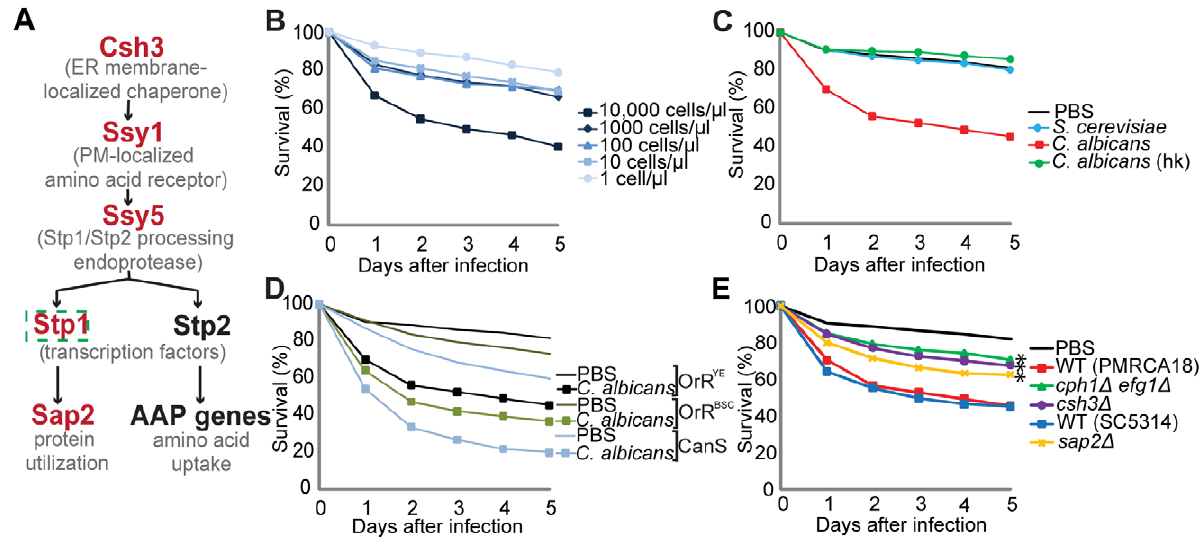
Figure 1. Drosophila can be used as a model of C.albicans virulence. A. The epistatic relationships of the components of the SPS sensing pathway in C. albicans . Strains carrying null alleles of the genes in red type exhibit reduced virulence in the Drosophila host model. The dashed-line around STP1 indicates that this gene is nitrogen regulated, and is only expressed under conditions of limiting nitrogen-source availability. Stp1 activates genes involved in host protein degradation and utilization, such as the gene encoding the Sap2 protease. Stp2 activates genes required for amino acid uptake, such as genes for amino acid permeases (AAPs). Note that Ssy1 is identical to Csy1 [14]; Ssy1 is used here since it is the standard name listed in the Candida Genome Database. B. Wild-type Drosophila (OrR YE ) flies are susceptible to virulent C. albicans infections and can be used as a model host to assess the virulence properties of mutant C. albicans strains. Ten-fold serial dilutions (ranging from 10,000 cells/ m l to 1 cell/ m l as indicated) of C. albicans (PMRCA18) exhibit dose-dependent lethality in OrR flies (n=500). C. OrR flies (n=500) were injected with PBS, S. cerevisiae (KRY001), viable or heat-killed (hk) C. albicans (WT). Fungal cells were suspended at a concentration of 10,000 cells/ m l. D. Different wild-type Drosophila lines, OrR YE , a newly obtained OrR line (OrR BSC ) and CantonS, were injected with PBS or C. albicans (WT; PMRCA18) at 10,000 cells/ m l. E. Flies (n=500) were injected with PBS, C. albicans WT (PMRCA18 or SC5314), cph1 D efg1 D , csh3 D , or sap2 D suspended at 10,000 cells/ m l. Statistically significant differences from the survival of the flies injected with WT C. albicans are marked by an